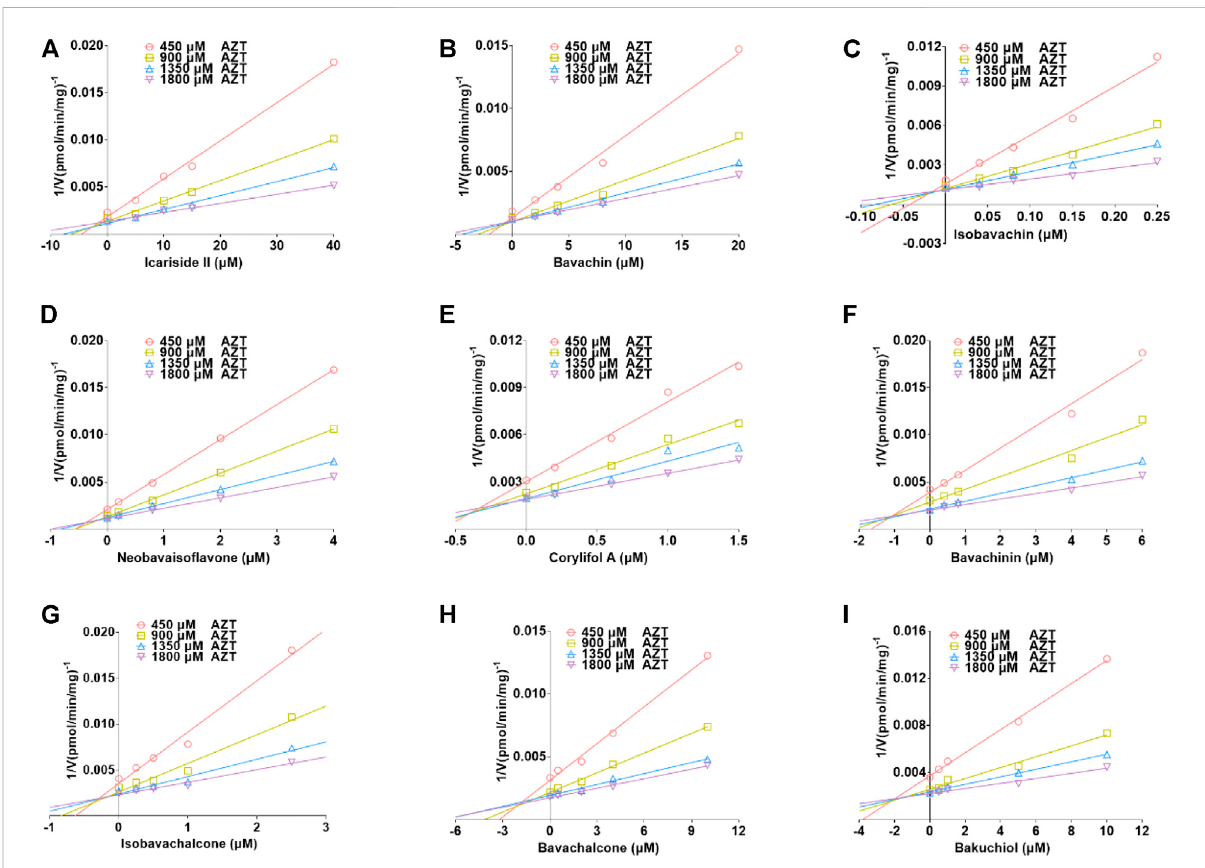
FIGURE 6 Dixon plots for the inhibitory effects of icariside II (A) , bavachin (B) , isobavachin (C) , neobavaiso fl avone (D) , corylifol A (E) , bavachinin (F) , isobavachalcone (G) , bavachalcone (H) , and bakuchiol (I) against zidovudine- N -glucuronidation for UGT2B7. All data were shown as means ± SD of triplicate determinations ( n =